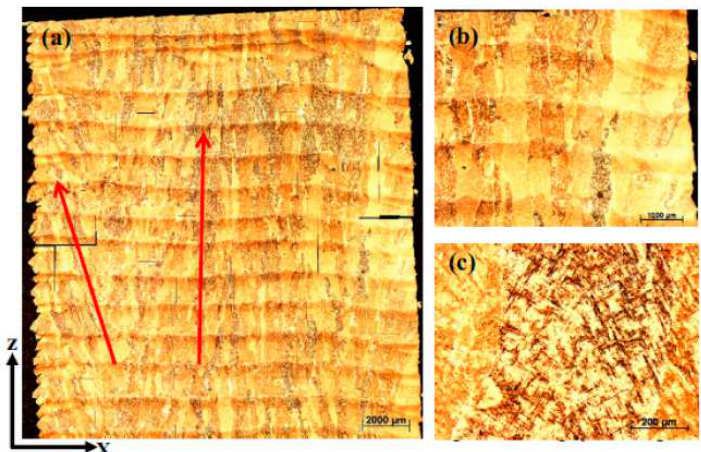
Figure 2. Typical macrostructure and microstructure of as-deposited sample of Ti6Al4V: ( a ) grain structure in as-deposited sample; ( b ) x-sectional micrograph; ( c ) z-sectional micrograph (adapted from